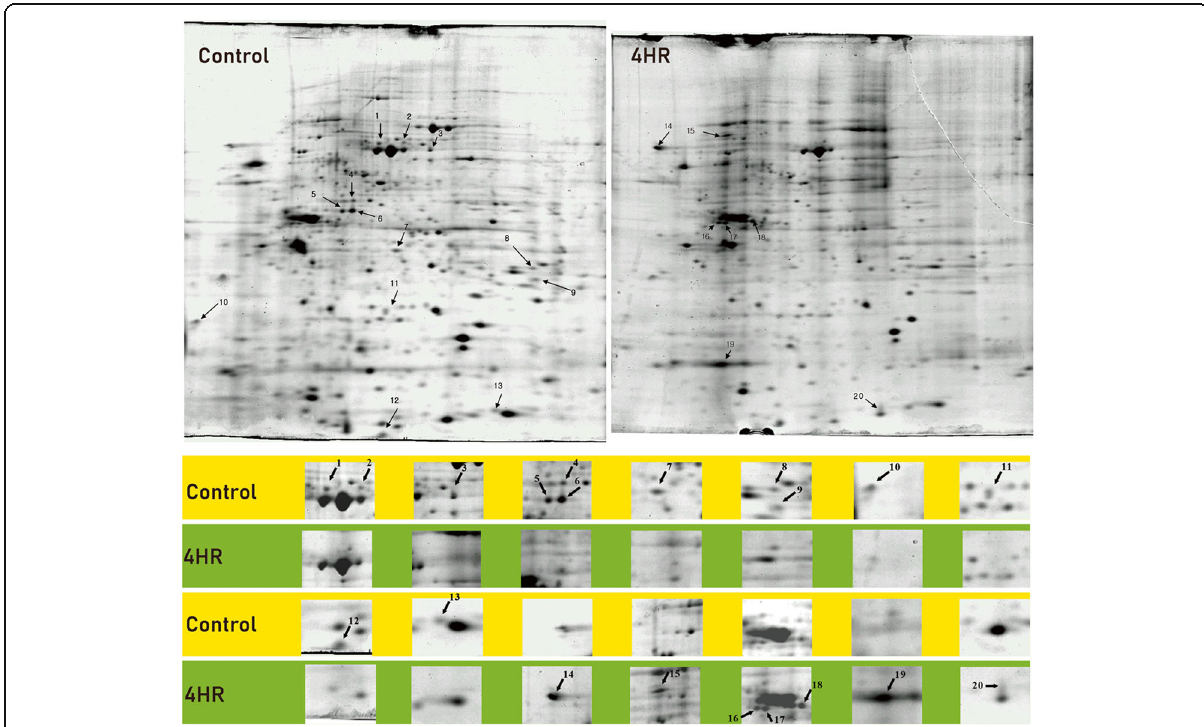
Fig. 1 Two-dimensional gel electrophoresis and proteomic analysis. SCC-9 cells were cultured to confluency and treated with 4HR-treated (100 μ g/ml) for 24 h. Cell lysates were analyzed by 2D gel electrophoresis. Differential expression protein spots were observed in 2D electrophoregrams from control ( A , C , E , G ) and SCC-9 cells ( B , D , F , H ). Highly expressed keratin 1 ( D ), keratin 10 ( F ), and histone H2B protein (H2BFN) ( H ) in 4HR treated cells were identified by quadrupole-time of flight mass spectrometry. Arrows 1, 2, and 3 indicated keratin 1, keratin 10, and H2BFN,